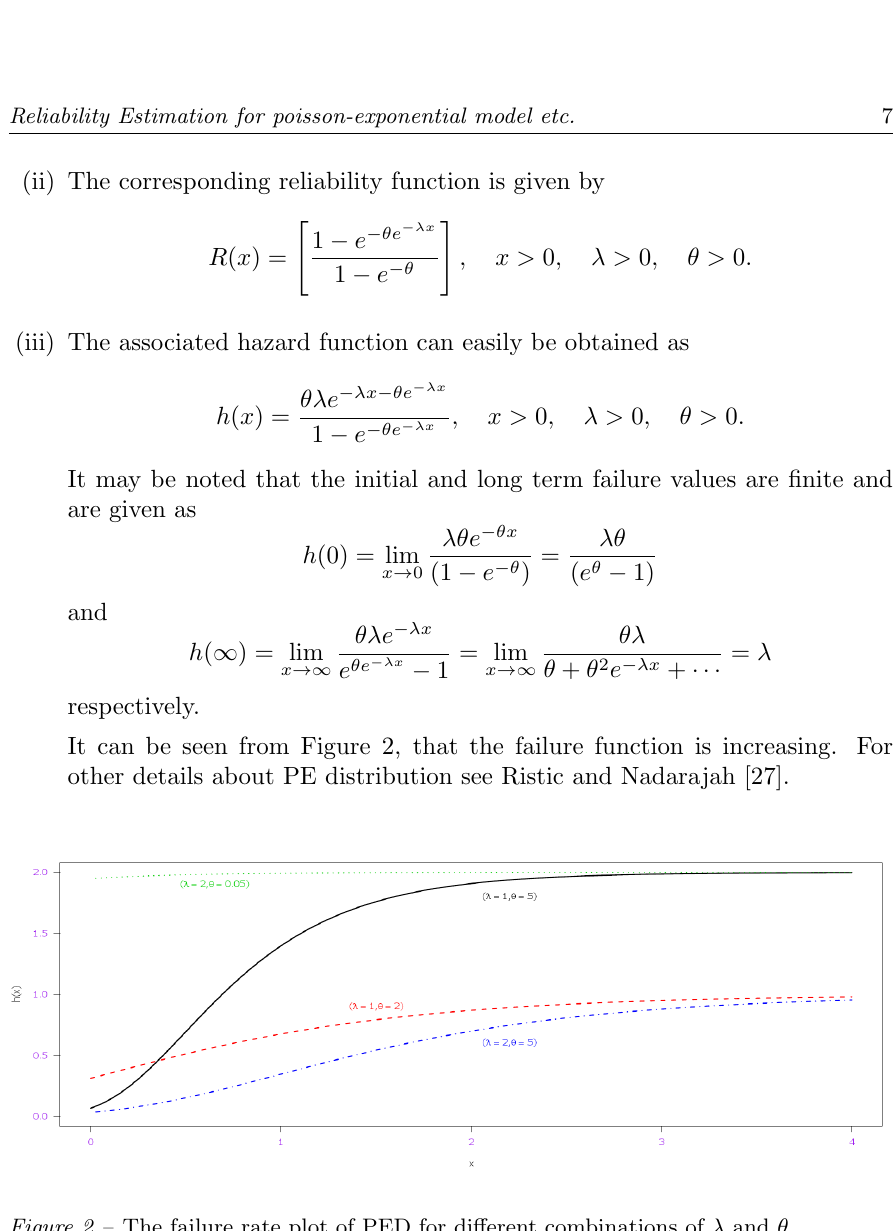
Figure 2 – The failure rate plot of PED for different combinations of λ and θ